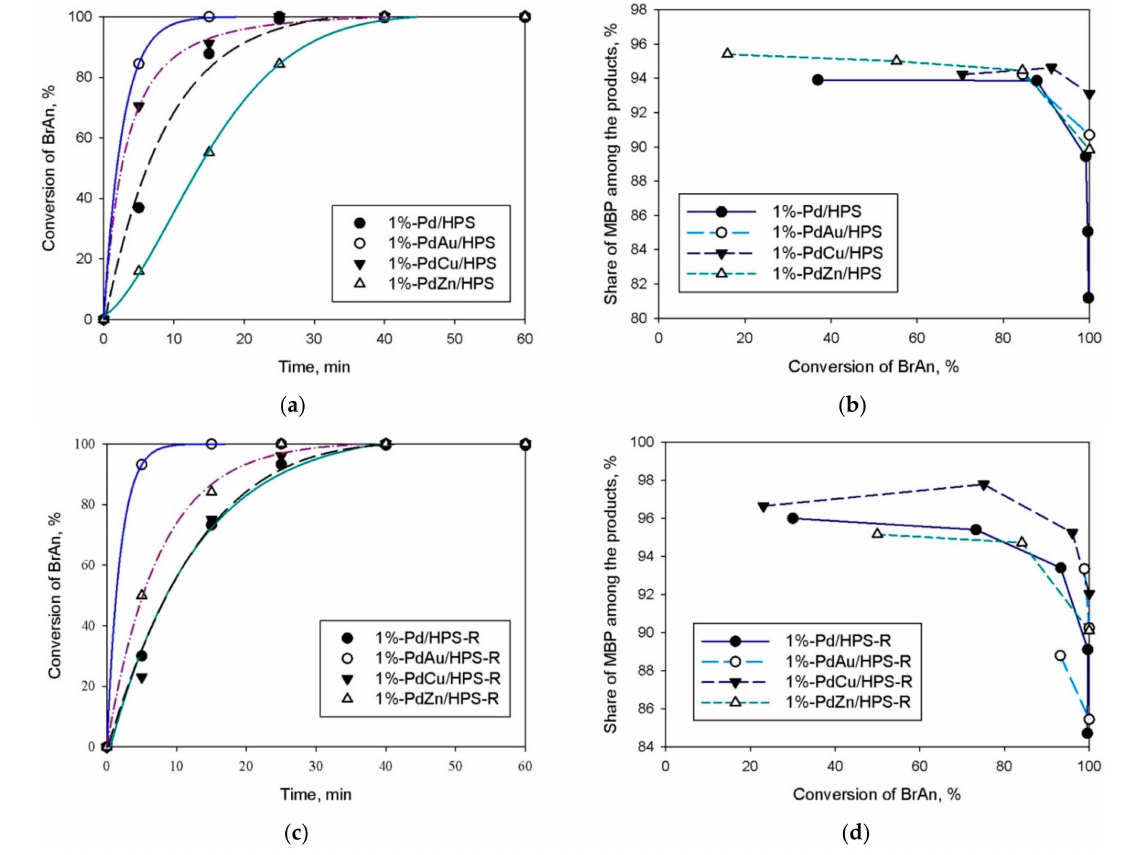
Figure 9. Dependence of BrAn conversion on time ( a , c ) and “selectivity” with respect to MBP vs. BrAn conversion ( b , d ) for synthesized mono- and bimetallic samples (in the catalyst’s designations “R” refers to preliminarily reduced samples); reaction conditions: 1 mmol of BrAn, 2.5 mmol of PBA, 3.0 mmol of NaOH, 60 ◦ C, 900 rpm, and 30 mg of catalyst.